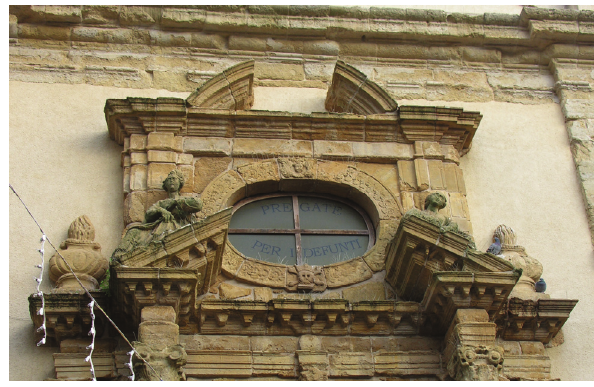
Figure 15. Detailed image of the portal entabled